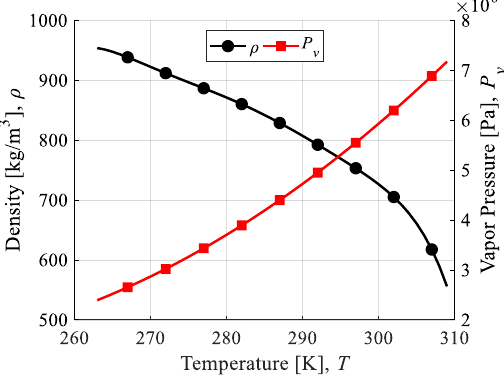
Figure 1. Thermodynamic properties of liquid nitrous oxide (N 2 O). 56